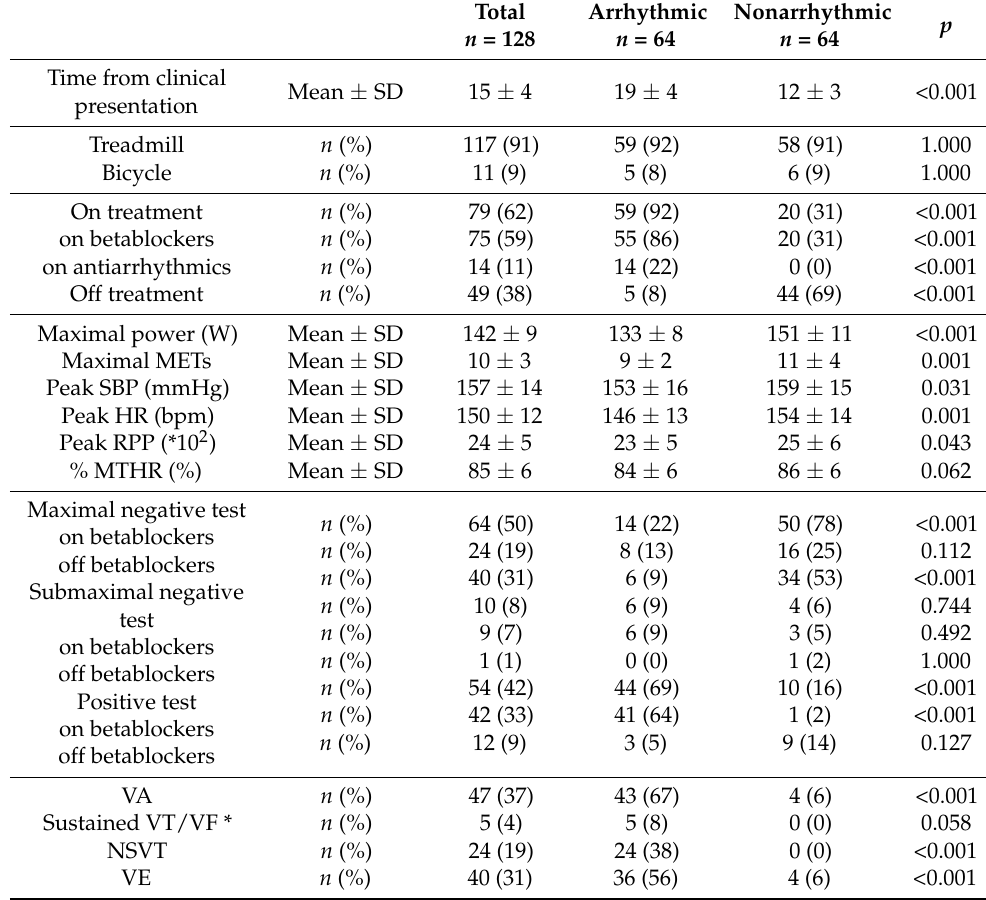
Table 2. Exercise stress